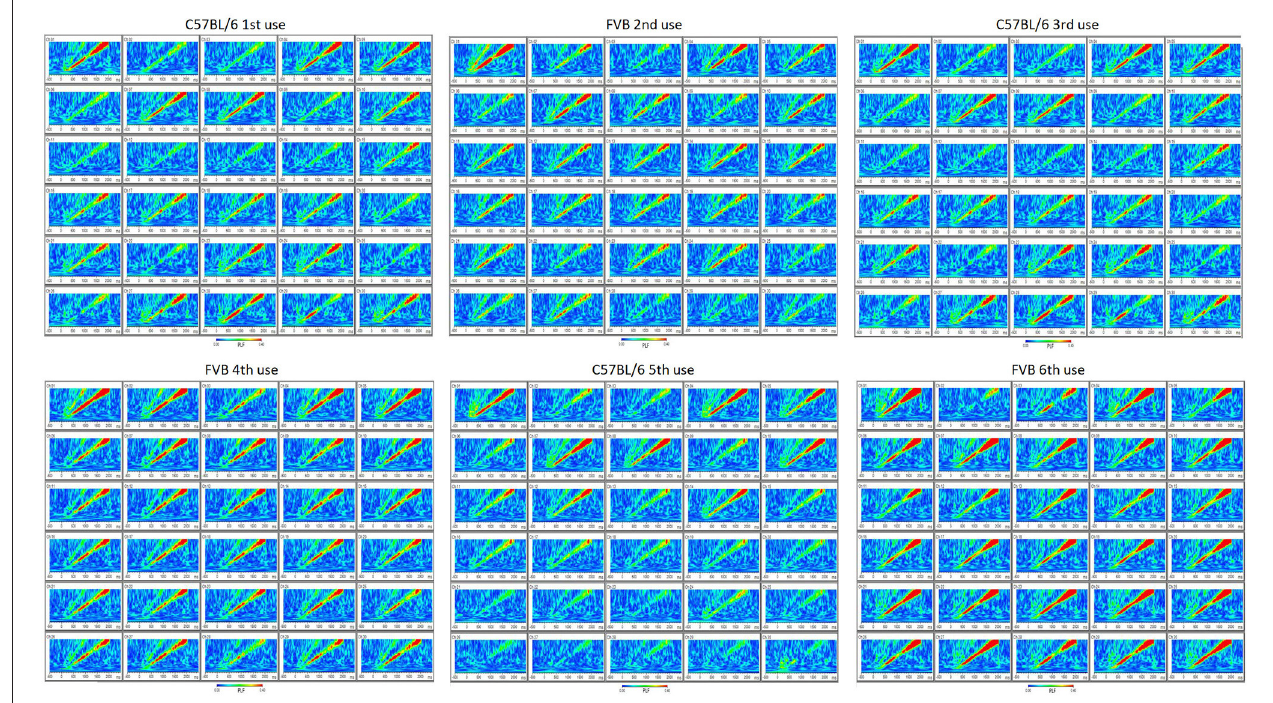
FIGURE 5 | Reusability of probe (up to six uses) is demonstrated by reproducibility of phase-locking factor (PLF) of EEG response to “up chirp” auditory stimulus from C57BL/6 and FVB mouse strains.